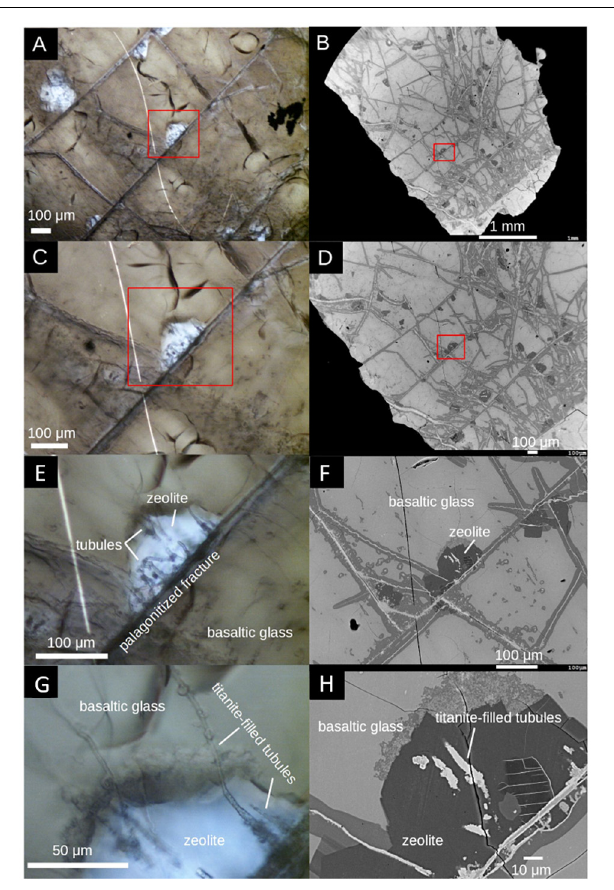
FIGURE 6 | Correlated optical (left column) and SEM backscattered electron (right column) imagery of a representative mineralized tubule location at various scales. (A–D) Zeolite-titanite assemblages occur along cracks and fractures that pervade the hyaloclastite glass. (E,F) Tubules are rooted on fracture surfaces. (G,H) Tubules within zeolites are mineralized by titanite, in contrast, tubules within basaltic glass are mainly